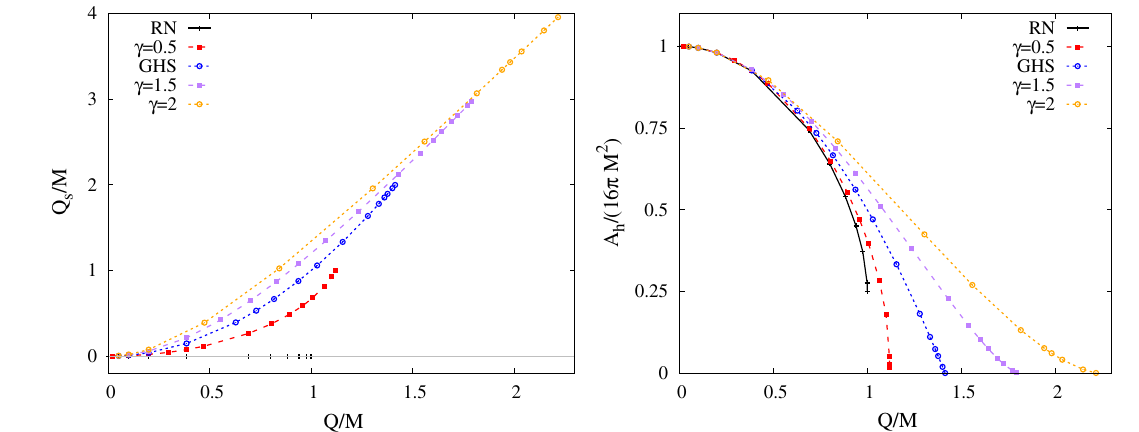
blue, purple and orange for γ = 0 . 5 , 1 , 1 . 5 and 2, respectively. (right) A similar figure for the scaled horizon area A